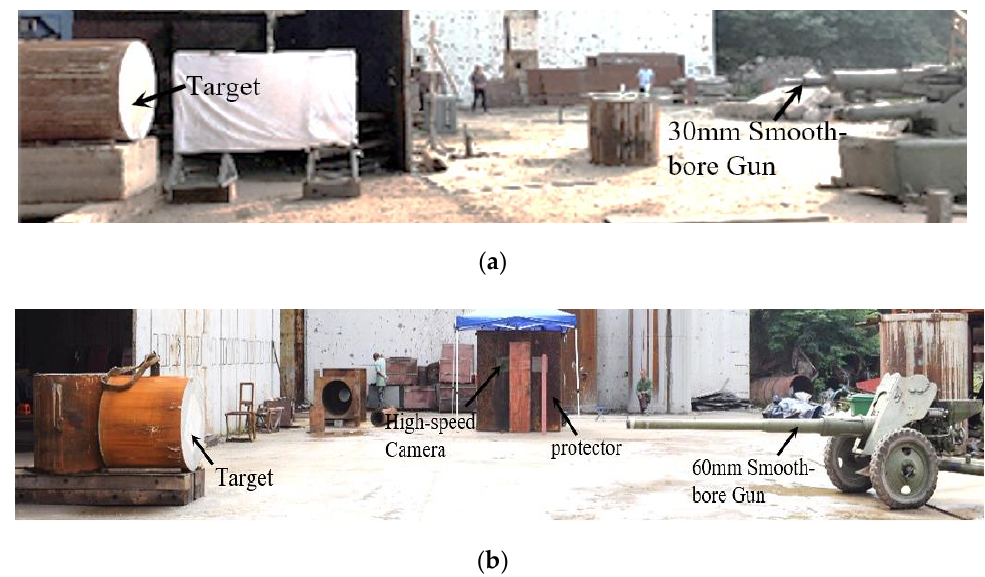
Table 3. Steel composition for 30CrMnSiNi2A.